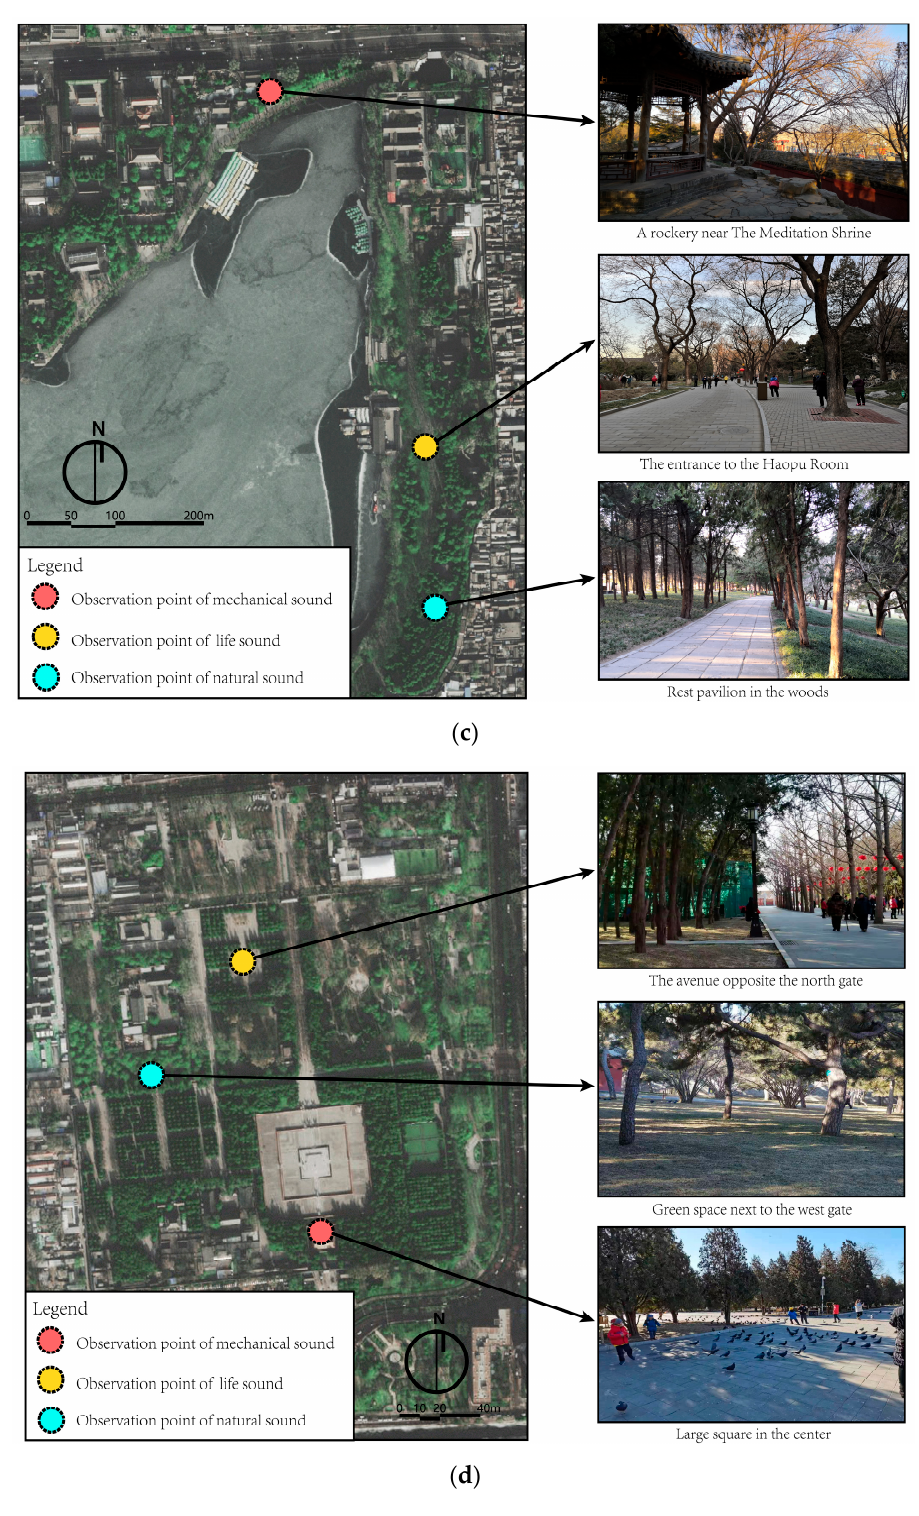
Figure 2. The specific sound pressure level observation points. ( a ) Olympic Forest Park; ( b ) Beijing Sun Park; ( c ) Beihai Park; ( d ) Ditan Park. Experiments were conducted on the weekends of August and November 2021. Au- gust is the high-temperature season in Beijing, and November is the beginning of the low- temperature season in Beijing. Therefore, the two can be compared and both periods are